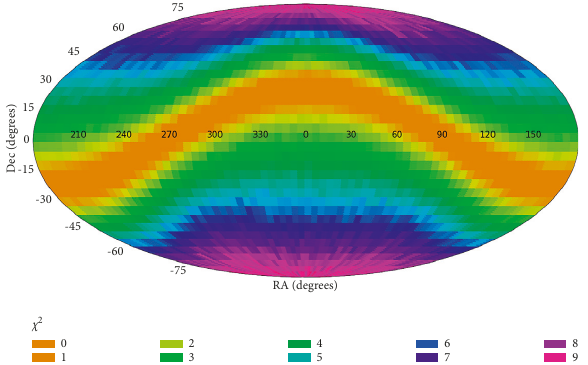
Figure 10: Analysis of a dipole axis when using 7 . 7 · 10 4 SDSS galaxies and assigning 2% of the galaxies with clockwise spin di- rection regardless of their actual spin direction. The axis peaks exactly at the celestial pole, with a very strong statistical